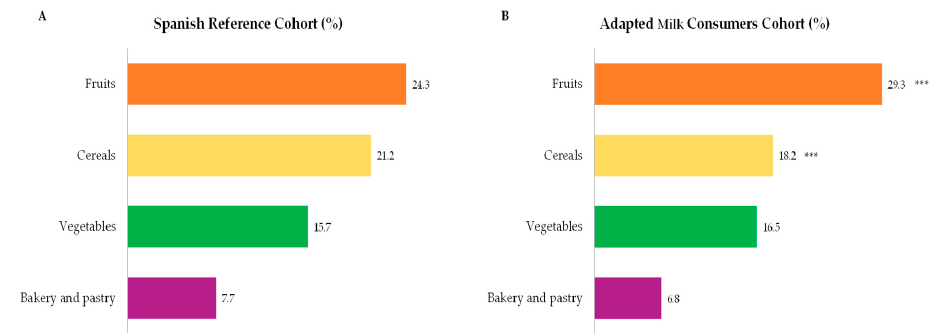
Figure 5. Dietary food and beverage groups contributing to total fiber intakes (%) from the EsNuPI study population (“Spanish Pediatric Population”) in both the Spanish Reference Cohort ( A ) and the Adapted Milk Consumers Sample ( B ). *** p ≤ 0.001 compared to reference cohort (Mann-Whitney test). Only foods contributing ≥ 0.1% to total carbohydrates intakes of the population have been included.